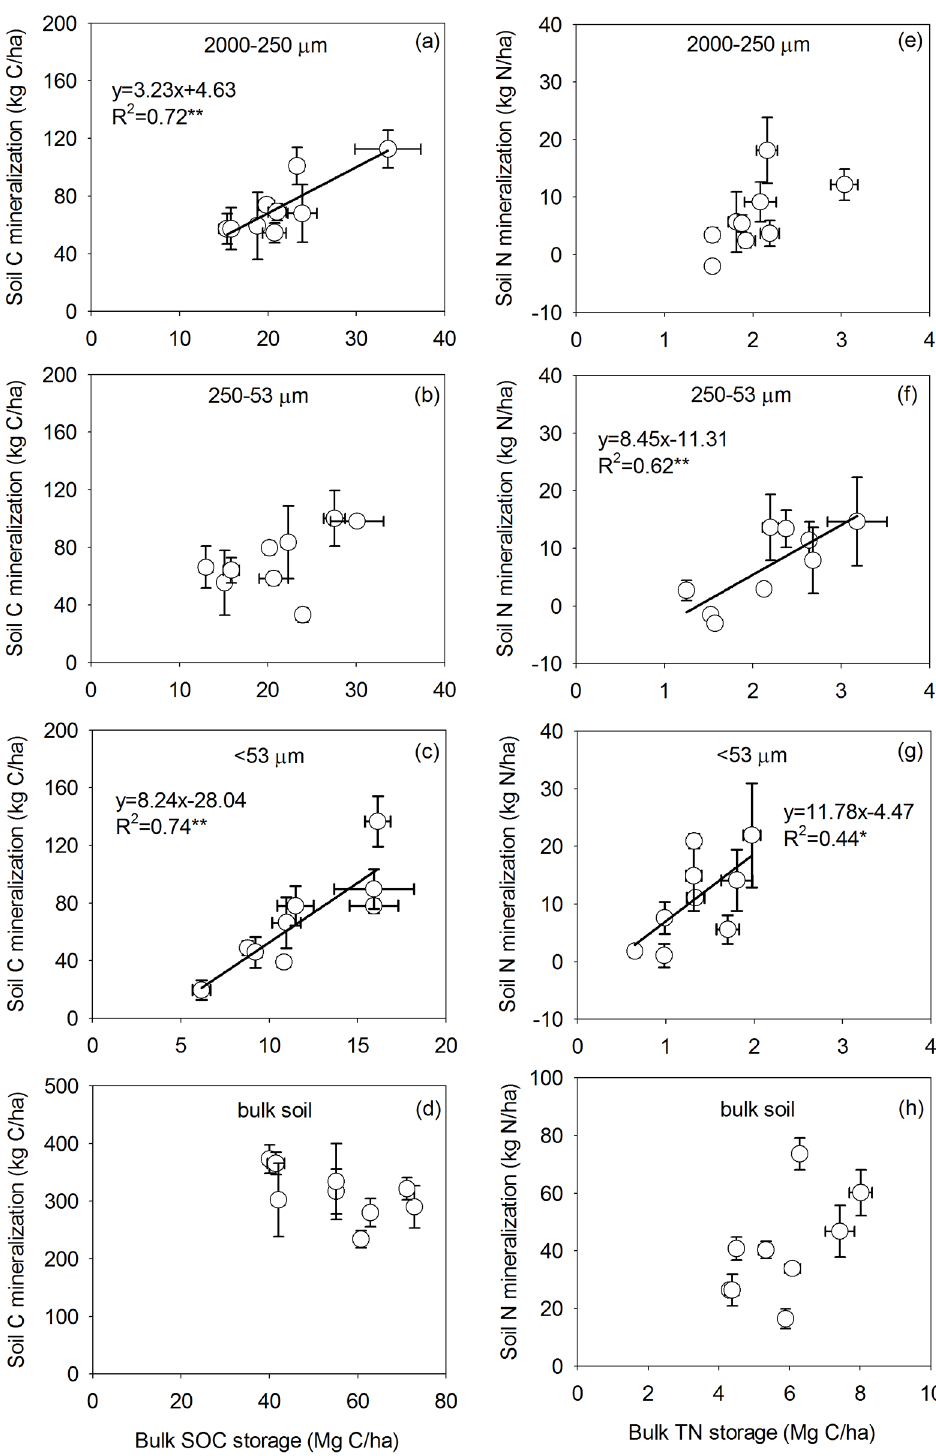
Fig 4. Relationship between soil organic carbon (SOC) storage vs potential carbon (C) mineralization, and total N storage, potential nitrogen (N) mineralization in 2000 – 250 μ m, 250 – 53 μ m, < 53 μ m fraction and bulk soil after 32 years of manure